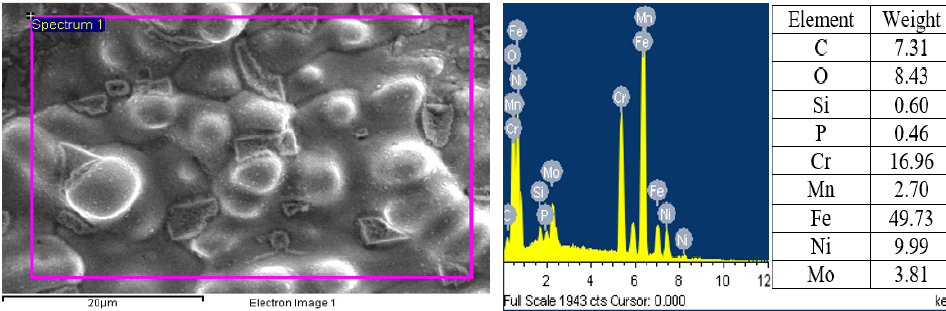
Figure 9. EDS spectral analysis in the lateral solidification cracking face of the specimen welded without coating powder.